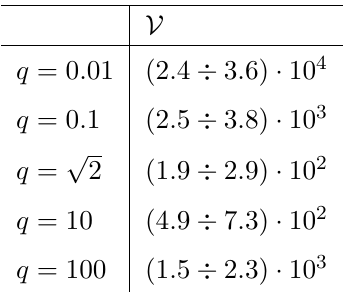
and m masses as a function of the axion DM fraction varying the ratio Figure 5 . We show m d d f b between the decay constants q = f . Top: when q ≤ 1 the contributions coming from d b /f f negligible and its mass becomes (cid:28) 10 − 40 eV. Bottom: when q ≥ 2 the contributions coming from d f are negligible and its mass becomes (cid:28) 10 − 40 eV. The maximum and minimum values of the parameters used to compute the allowed mass range can be found in table 2. In these plots, we assumed for simplicity that A = A given that, considering small and large q values, a relative f b variation of these parameters does not have any impact on the predictions.